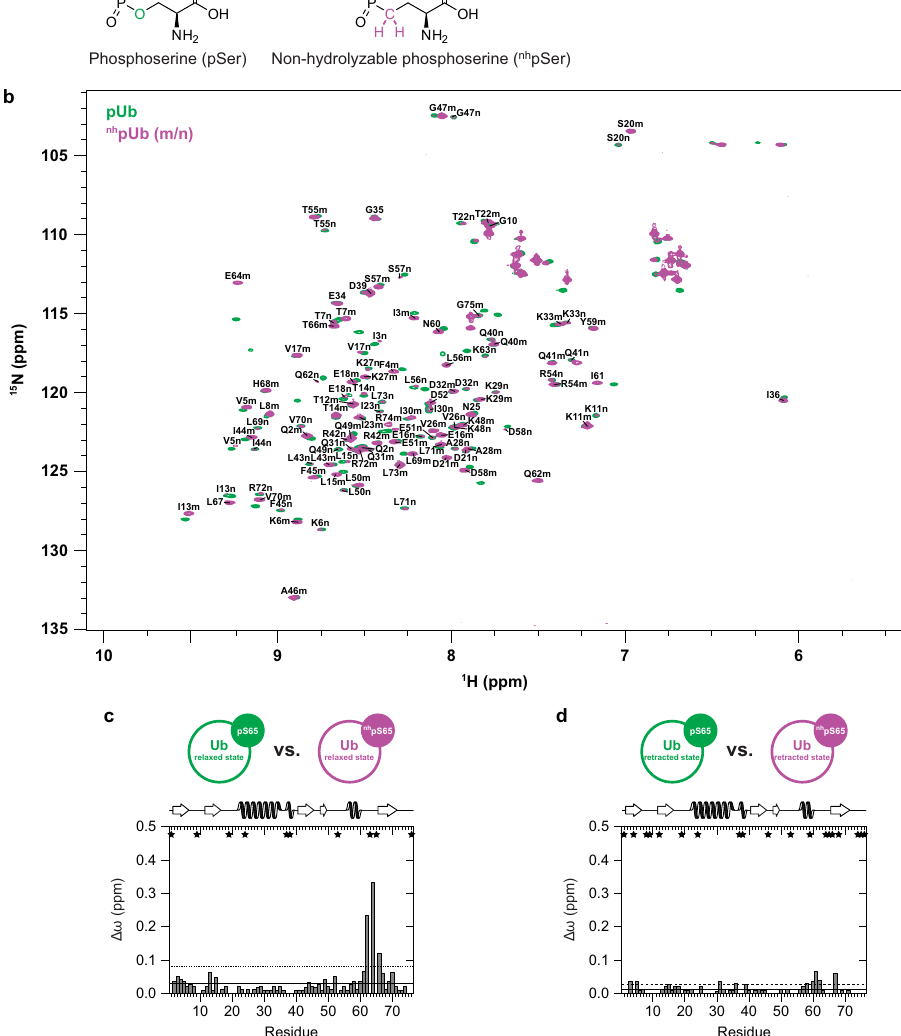
Fig. 3 NMR spectroscopic characterization of nh pUb. a Structure of L -O-phosphoserine (pSer) and its non-hydrolyzable analog L -2-Amino-4- phosphonobutyric acid ( nh pSer). b Two-dimensional heteronuclear 1 H – 15 N HSQC NMR spectra of pUb (colored in green) and nh pUb (colored in purple) are superimposed. Assigned backbone amide resonance signals from the relaxed state (m) and the retracted state (n) of nh pUb are labeled in the spectrum by using the one letter code for amino acids. c , d Weighted chemical shift perturbation (CSP, Δω ) mappings comparing either the relaxed states ( c ) or the retracted states of pUb and nh pUb with each other ( d ). Δω values exceeding the horizontal straight line are larger than the mean and Δω values exceeding the horizontal dashed line are larger than the mean plus one standard deviation. Residues that could not be assigned in both Ub species are indicated by an asterisk. Secondary structure elements according to the NMR solution structure of Ub (PDB ID 1D3Z) 74 are depicted on top of the